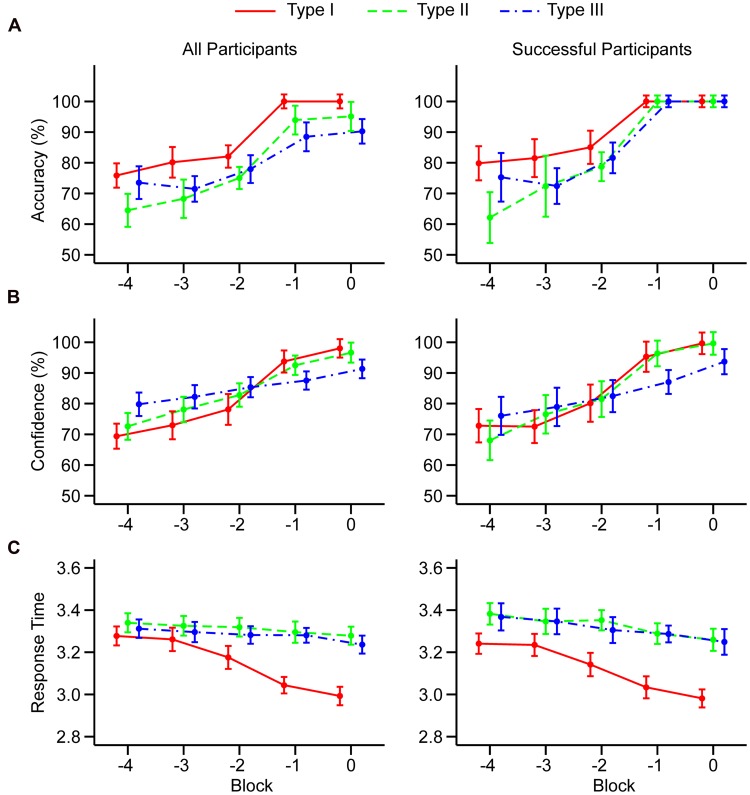
Mean accuracy (A), confidence judgments (B), and log10 transformed response times (C) in the last five learning blocks. Results are shown separately for all participants (left column) and for participants who successfully learned all three tasks (right column). Blocks are counted relative to the end of the learning session. Error bars represent 95% within-subjects confidence intervals computed following Cousineau (2005) and Morey (2008).